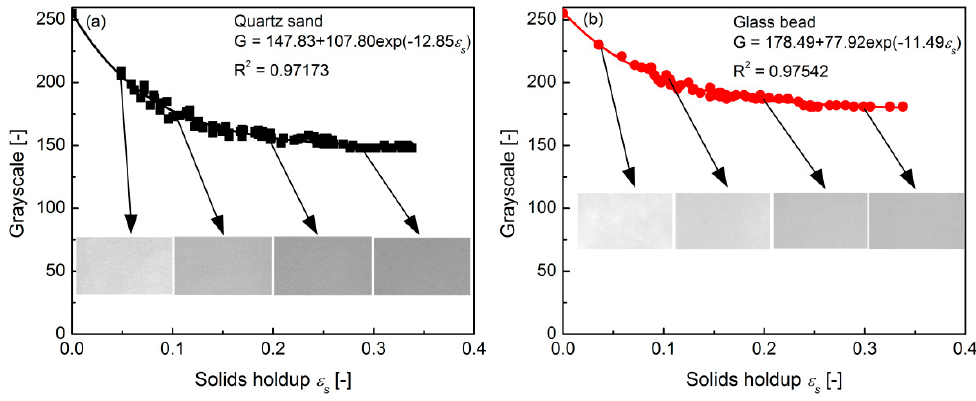
Figure 11. Calibration curve of Group B particles. ( a ) Quartz sand. ( b ) Glass bed.